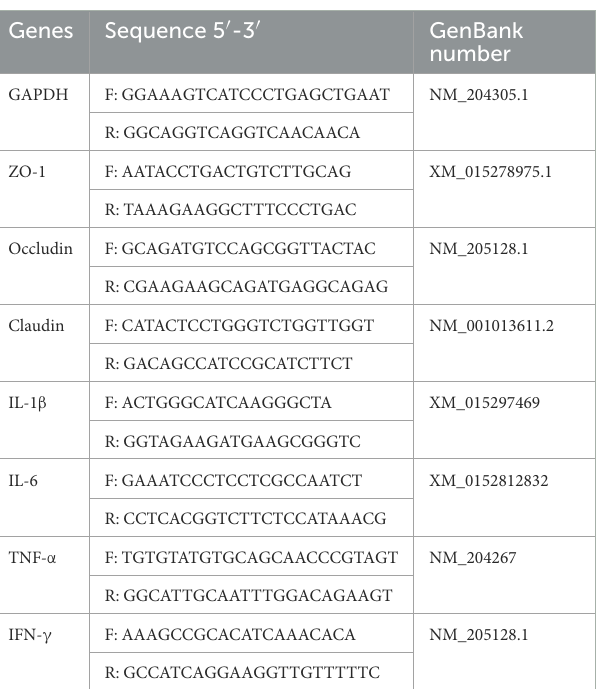
TABLE 3 Primer sequences were used for the real-time PCR analysis. TABLE 4 The effect of FCHM on growth performance of broiler